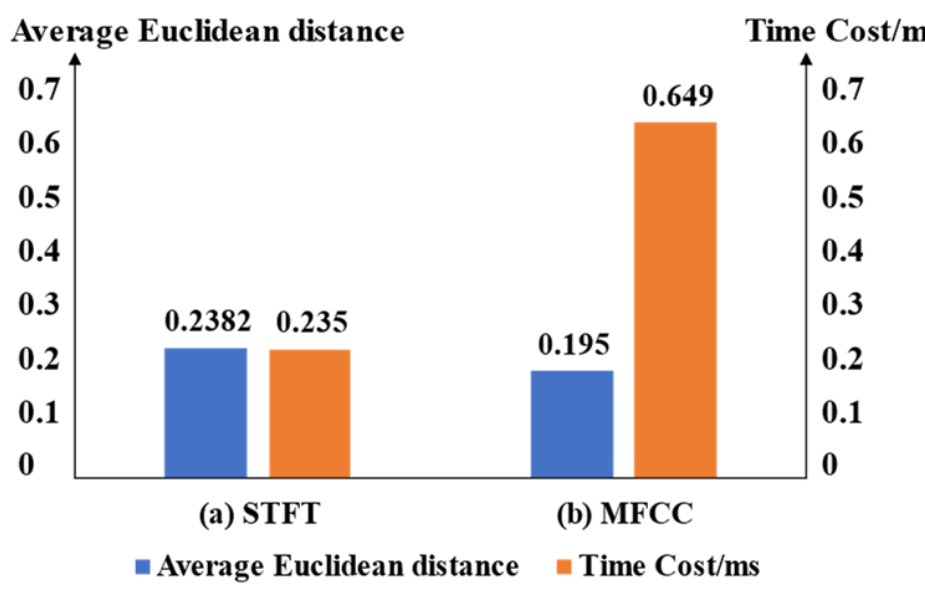
Figure 5. Comparison of the average Euclidean distances and the time cost with different features: ( a ) STFT, ( b ) MFCC.